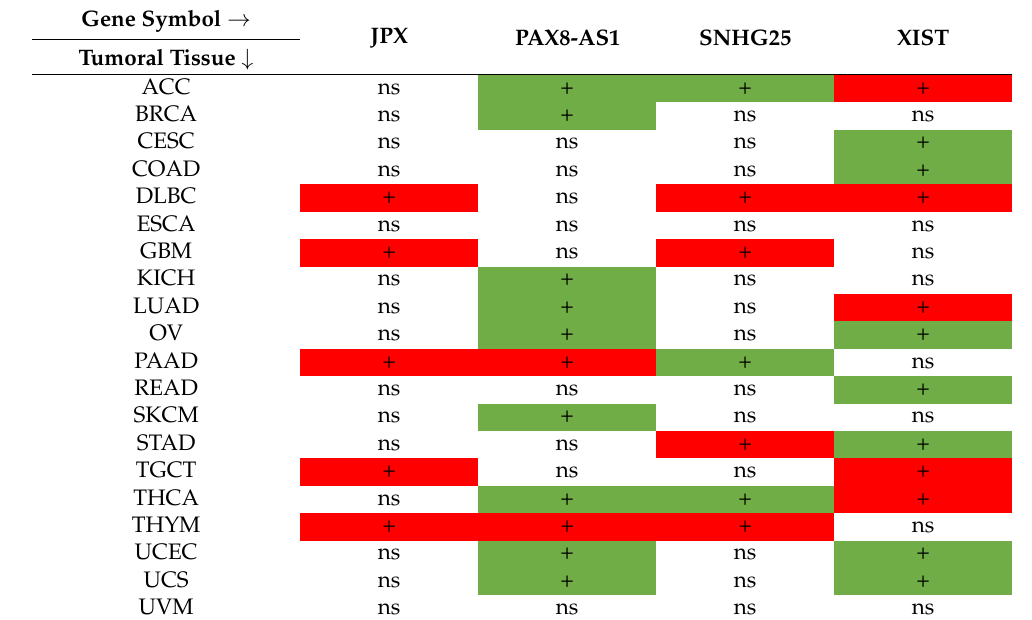
Table 8. Correlation of lncRNAs with expression in cancer. Deregulation has been investigated in tu- moral versus healthy tissue using GEPIA2 database and reported as ns (non-significant